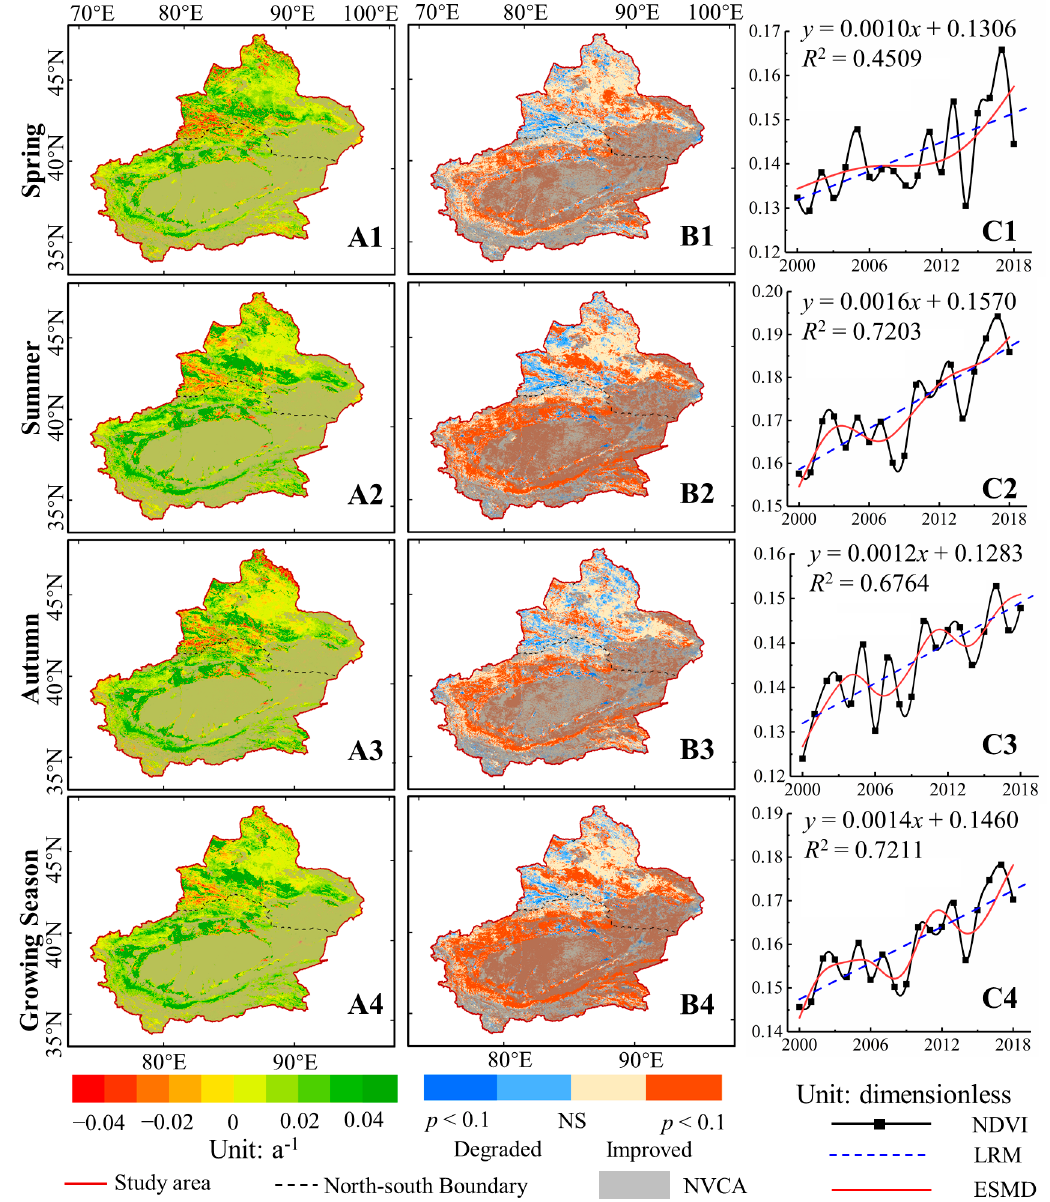
Figure 7. Spatial-temporal change of NDVI in Xinjiang during 2000–2018. ( A ) and ( B ) are the variation and its significance of NDVI. ( C ) denotes the interannual variations and the trends of NDVI. The NS represents the correlation is not significant. The NVCA denotes the non-vegetation covered areas.